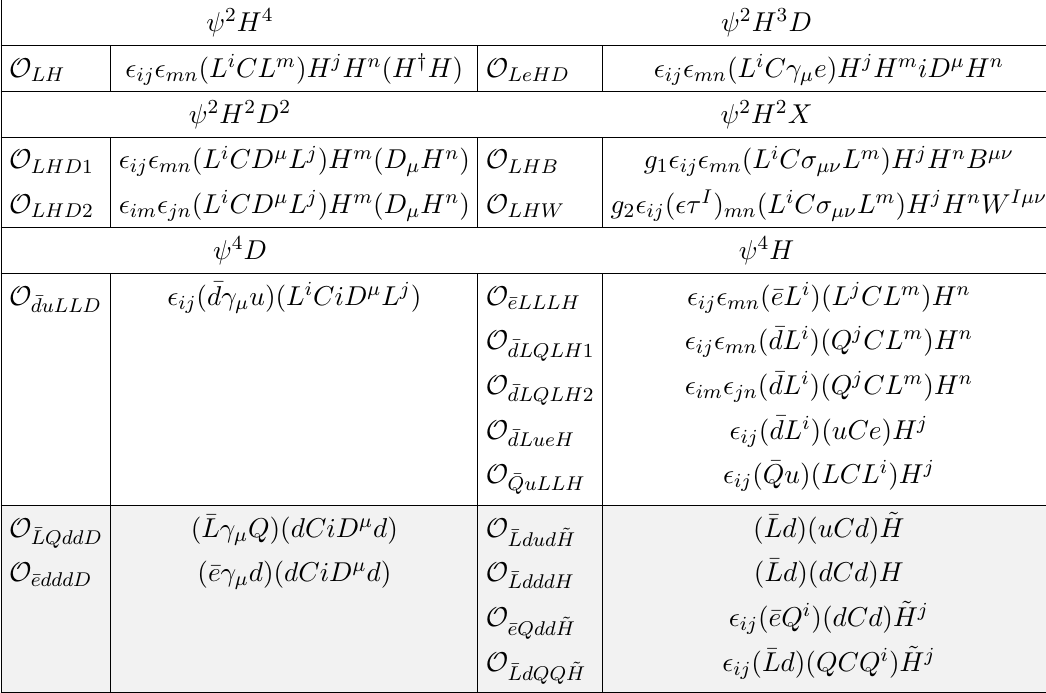
Table 4 . Dim-7 operators in 6 classes are divided into two subsets with L = 2 and B = 0 and B = (cid:0) L = 1 (in gray) respectively, where ( D (cid:22) H n ) should be understood as ( D (cid:22) H ) n etc. This table is taken from ref.